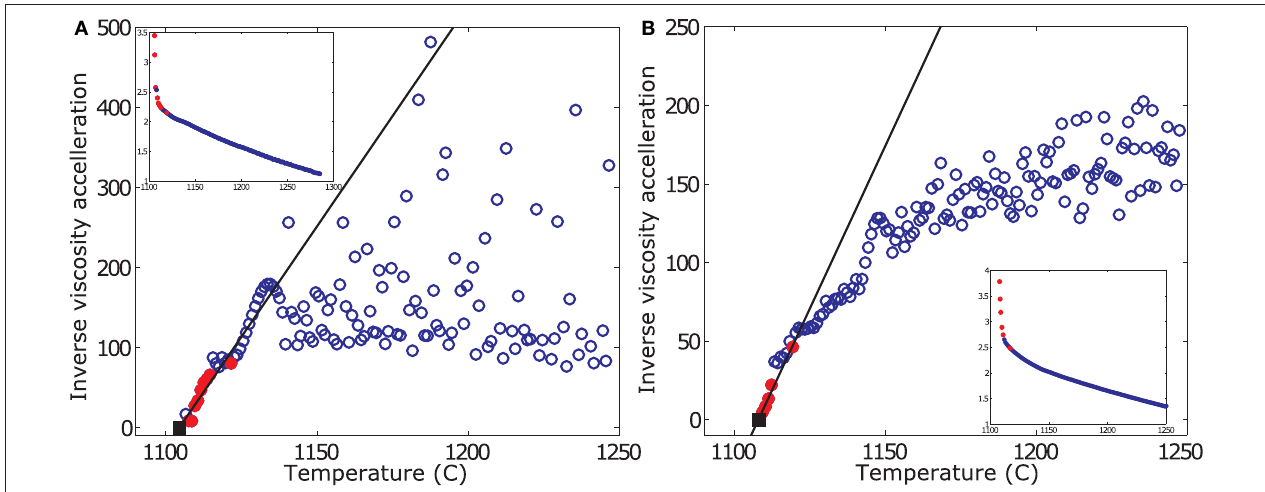
FIGURE 4 | Sample plot of TFM results, showing inverse viscosity acceleration rate vs. temperature. Data are plotted for a cooling rate of 1 K/min reducing and oxidizing conditions in are plotted in subplots (A,B) , respectively. Small inserts show the respective viscosity measurement. Blue open circles report the measured data interpolated at 1 degree intervals. Red filled circles highlight the peak acceleration values used in the TFM for fitting of the linear viscosity acceleration model to extrapolate to T cutoff . Black squares represent the forecasted T cutoff (i.e., d η /dT = ∞ ). The precision of the viscosity measurement is ± 3%.